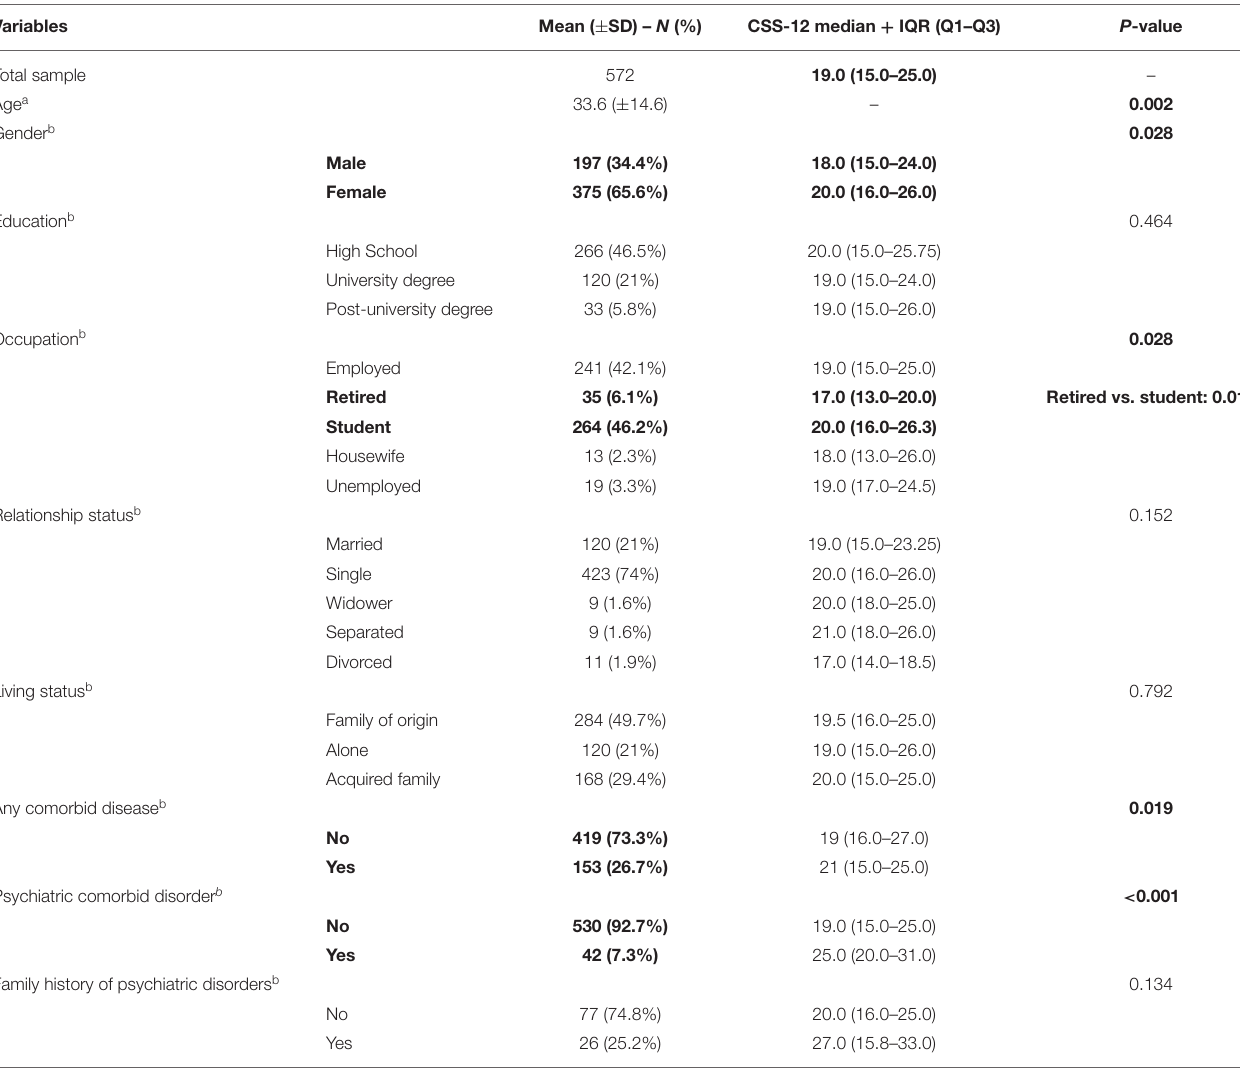
TABLE 1 | Socio-demographic variables showing a statistically significant difference on the Cyberchondria Severity Scale (CSS-12).